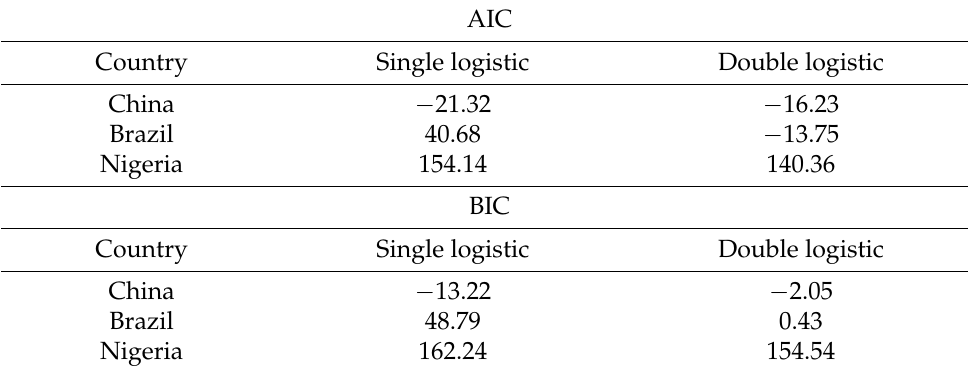
Table A1. The AIC and the BIC ratios of the single and the double logistic function of the life expectancy gap for China, Brazil, and Nigeria. The lowest values of AIC and BIC for each country are marked in